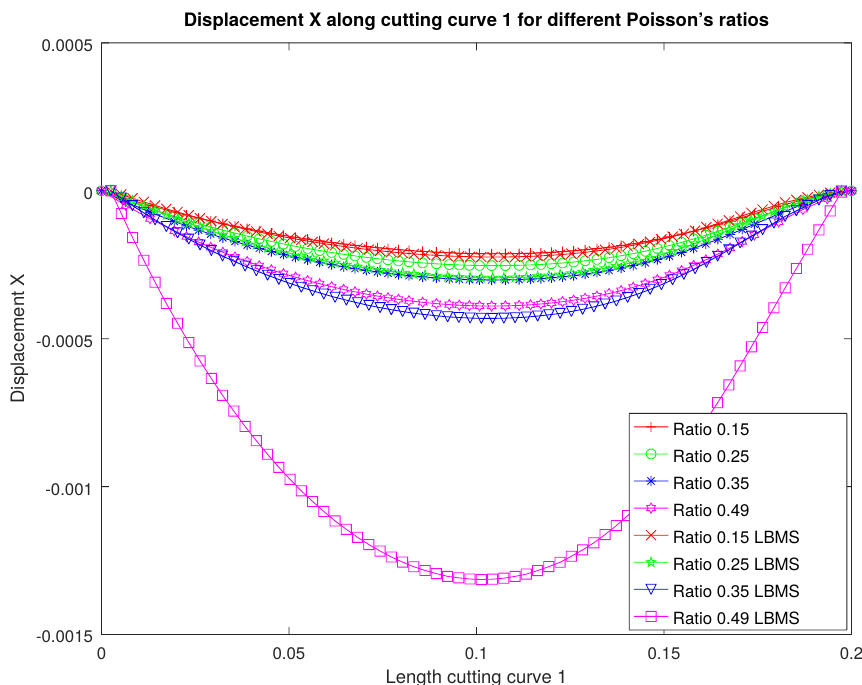
Figure A5. First displacement components along cutting curve C 1 for positive Poisson’s ratios.